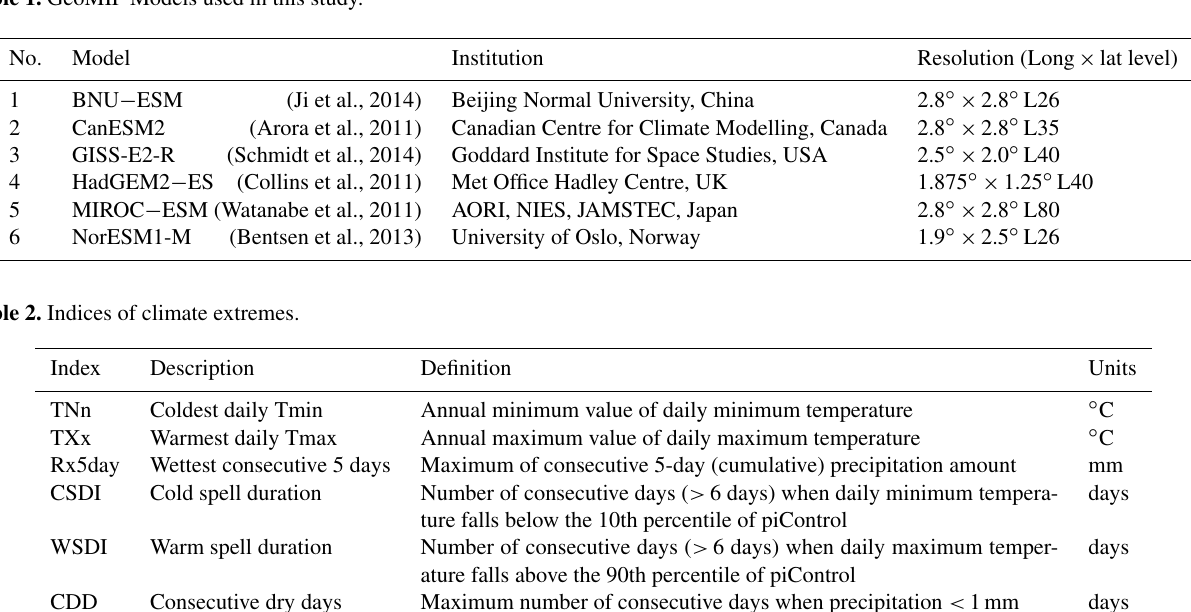
Table 1. GeoMIP Models used in this study.